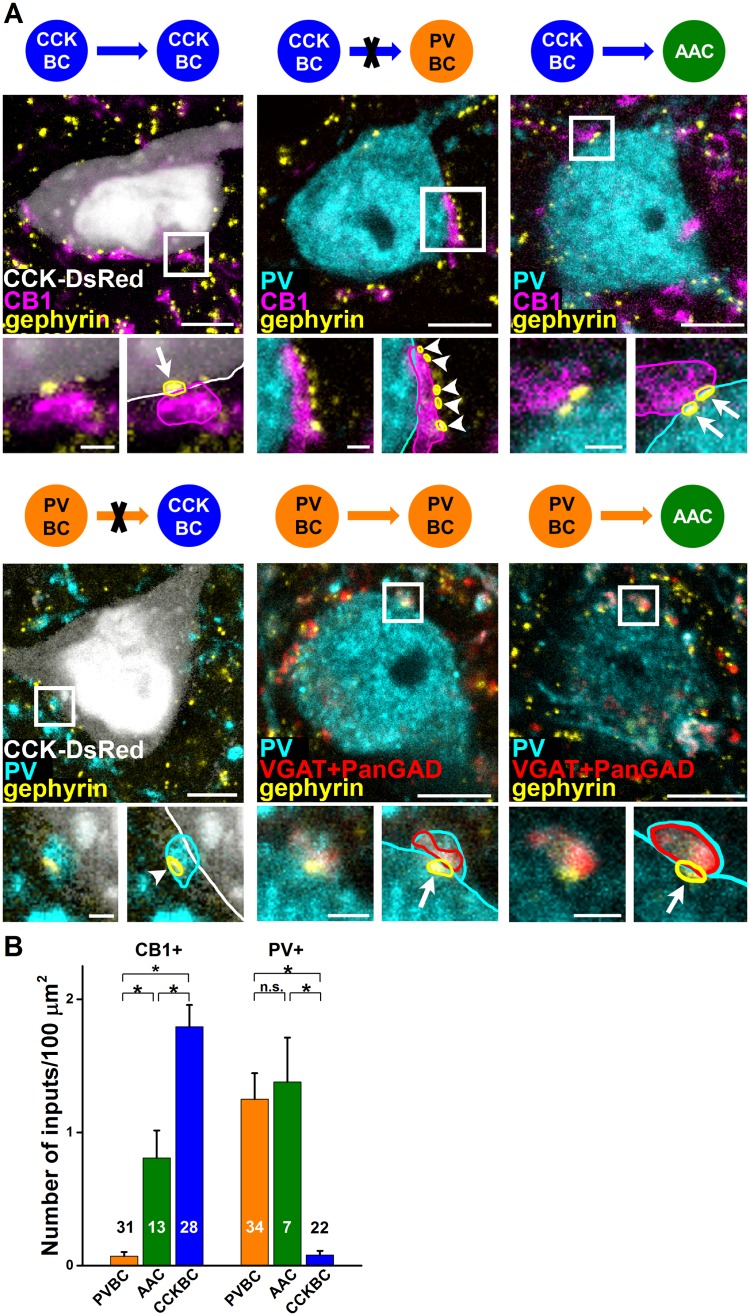
Cholecystokinin-expressing basket cells (CCKBCs) and parvalbumin-containing basket cells (PVBCs) avoid innervating each other but establish contacts on axo-axonic cells (AACs).(A) Quantification of somatic cannabinoid receptor type 1 (CB1)- and parvalbumin (PV)-expressing inhibitory inputs (arrows) onto CCKBCs, PVBCs, and AACs using fluorescent immunostainings against gephyrin, CB1, PV, and vesicular gamma-aminobutyric acid (GABA) transporter (VGAT)/glutamate decarboxylase 65/67 (PanGAD). Axon terminals contacting the interneuron soma and other structures are labeled with arrows and arrowheads, respectively. Delineation of the cell bodies, terminals, and gephyrin puncta are shown for clarity. Scales: 5 μm and 1 μm. (B) Density of CB1- and PV-immunostained terminals contacting the different types of perisomatic region-targeting interneurons (CB1 on PVBC: 0.06 ± 0.03; CB1 on AAC: 0.81 ± 0.21; CB1 on CCKBC: 1.79 ± 0.16; Kruskal-Wallis ANOVA, p < 0.001; PVBC versus AAC p < 0.001, PVBC versus CCKBC p < 0.001, AAC versus CCKBC p = 0.002, Mann–Whitney U test; PV on PVBC: 1.25 ± 0.19; PV on AAC: 1.38 ± 0.33; PV on CCKBC: 0.08 ± 0.03, Kruskal-Wallis ANOVA, p < 0.001, PVBC versus AAC p = 0.36, PVBC versus CCKBC p < 0.001, AAC versus CCKBC p < 0.001, Mann–Whitney U test)(S2 Data), labels on columns show the number of examined somata in each group. Mean ± SEM.